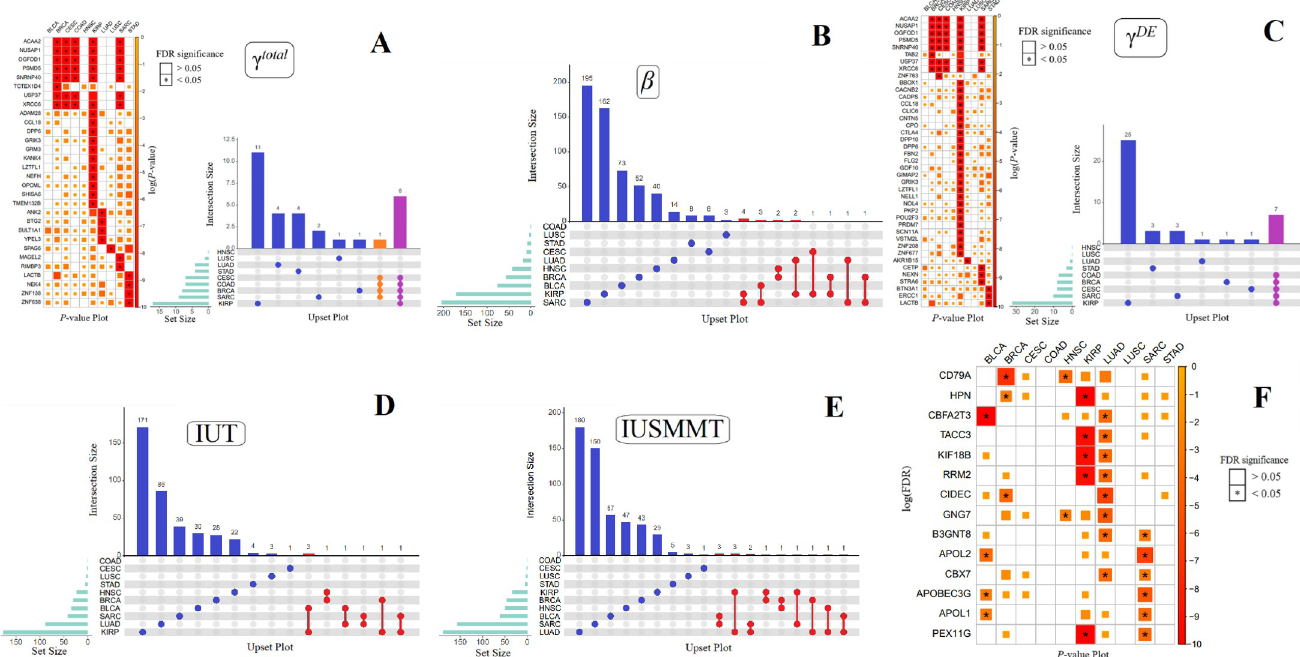
Fig 4. Upset plot and heatmap plot of the P -values ( A - F ). In the heatmaps of γ TE (A) and γ DE (C), the color of each box indicates the magnitude of the P -value. The number in the comment part represents the P -value processed by the negative logarithmic transformation. The darker the color, the smaller the P -value. In the Upset plots of γ TE , β , γ DE , IUT, and IUSMMT, each bar shows the number of shared genes. In these Upset plots, the blue part represents cancer type-specific genes, and the red, green, orange, and purple parts represent genes shared in two, three, four and five types of cancers. (F) The heatmap of the P -values of the 14 overlapped genes across all the cancers. The color of each box indicates the magnitude of the P -value. The number in the comment part represents the P -value processed by the negative log transformation, the darker the color, the smaller the P -value.